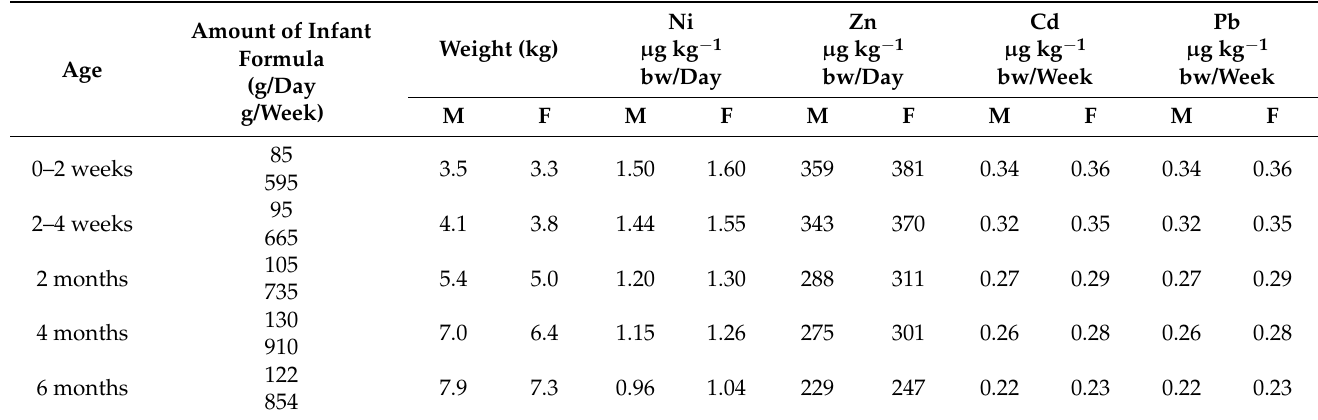
Table 7. Daily intake of Ni and Zn and weekly intake of Cd and Pb for infants from 0 to 6 months, separately for males (M) and females (F).